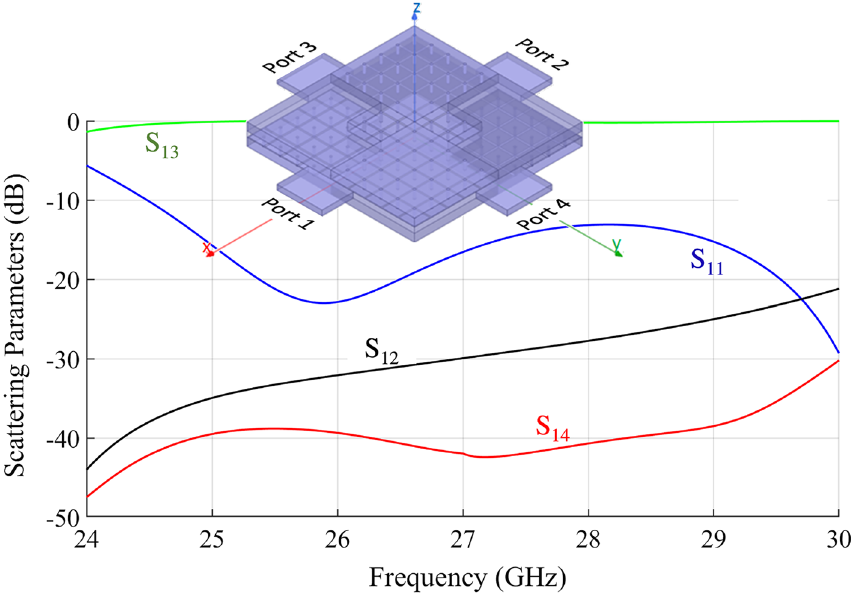
Figure 5. Simulated scattering parameters for the ELC coupler implemented through mushroom metasurfaces with 4x4 unit cells in the central